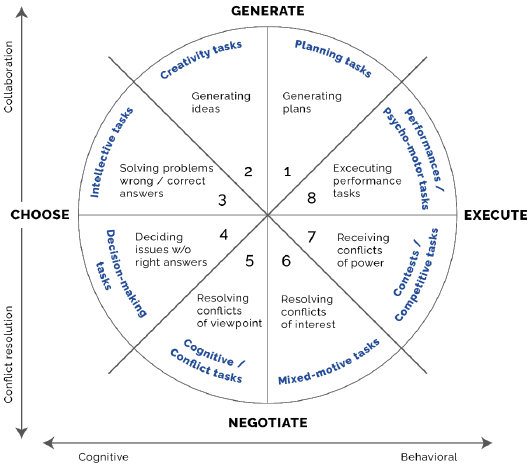
Figure 2. McGarth’s (1984) group task circumplex (figure redrawn).